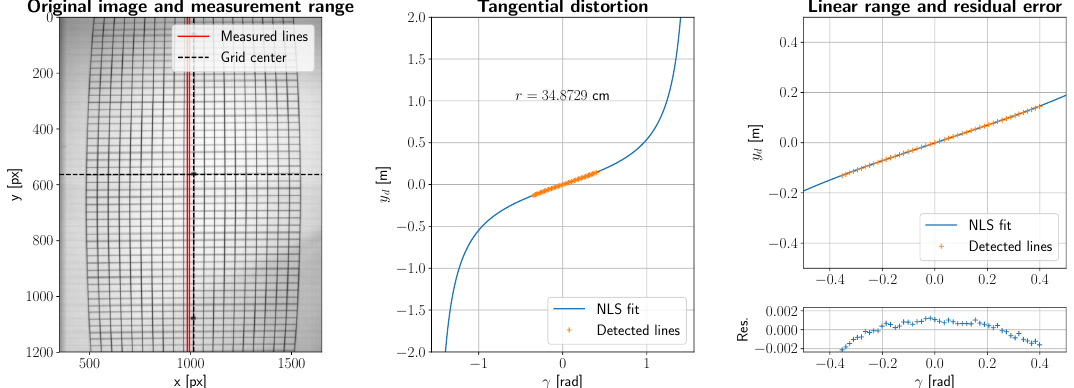
Figure 7. Tangential image distortions due to the selected rotating mirror configuration.